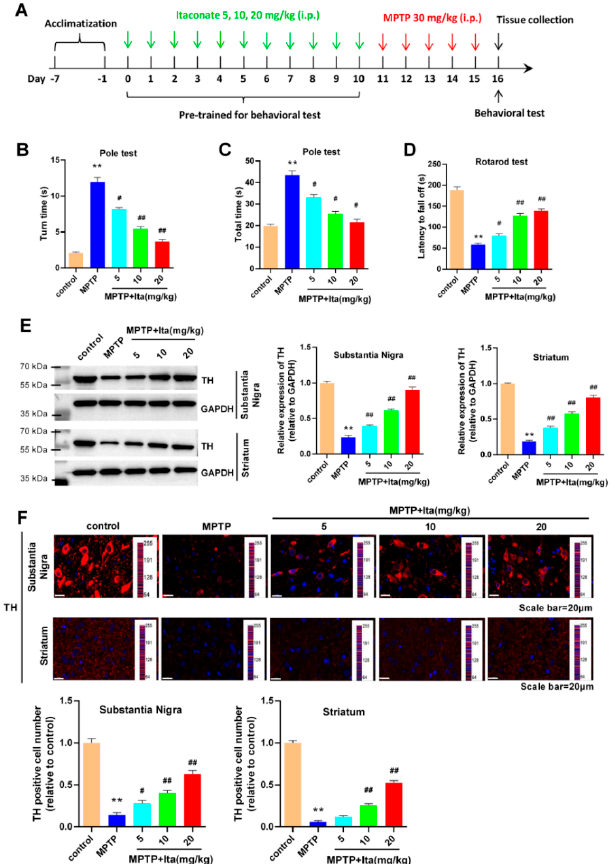
Figure 1. Itaconate attenuated motor deficits and dopamine neuronal damage in MPTP-caused PD mice model. ( A ) The experimental timeline of animal studies. Turn time ( B ) and total time ( C ) spent in the pole test. ( D ) Latency of falling off the rotarod. ( E ) The expression of TH in substantia nigra and striatum was measured using Western blotting. GAPDH serves as an internal control. ( F ) TH-positive cells in substantia nigra and striatum were assessed using immunofluorescence. The image acquisition parameters: objective (10 × ) and exposure settings (DAPI: 5 ms; TH: 200 ms). n =